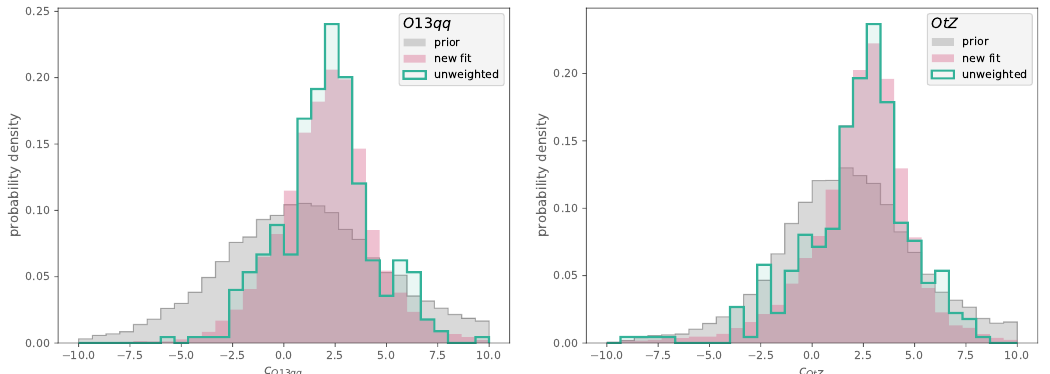
Figure 3.6: Same as Fig. 3.4 but for the Wilson coefficients mostly constrained by single-top s -channel production cross